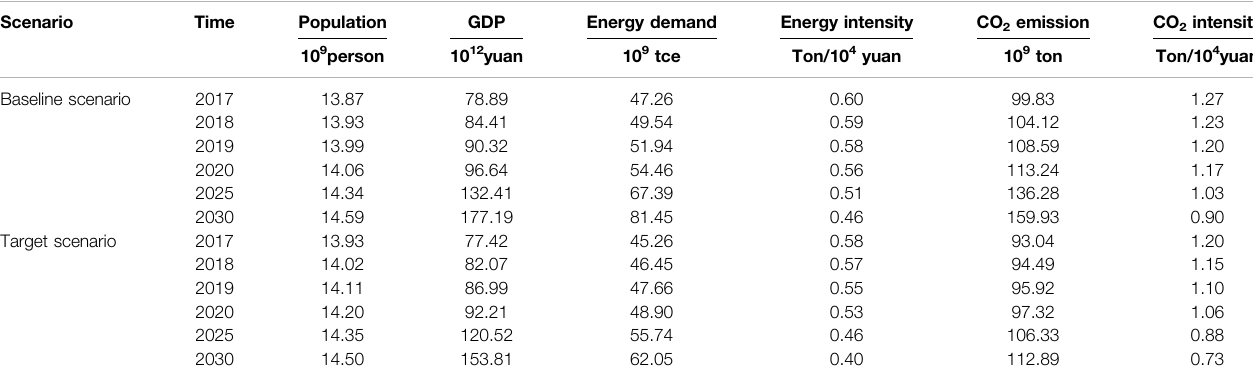
TABLE 2 | Basic prediction data.